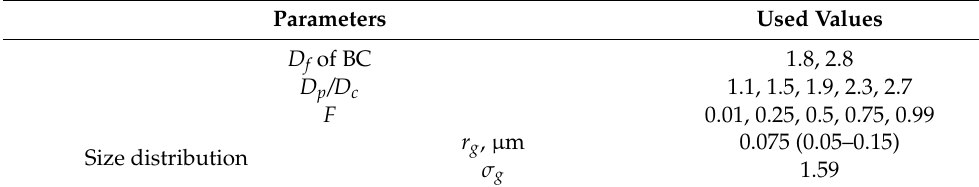
Figure 1. Modelled coated BC morphology. A fractal BC aggregate having 200 monomers is partially coated. The coated volume fraction of BC is 0.5 in this example. Table 1. Microphysical parameters for coated BC particles.